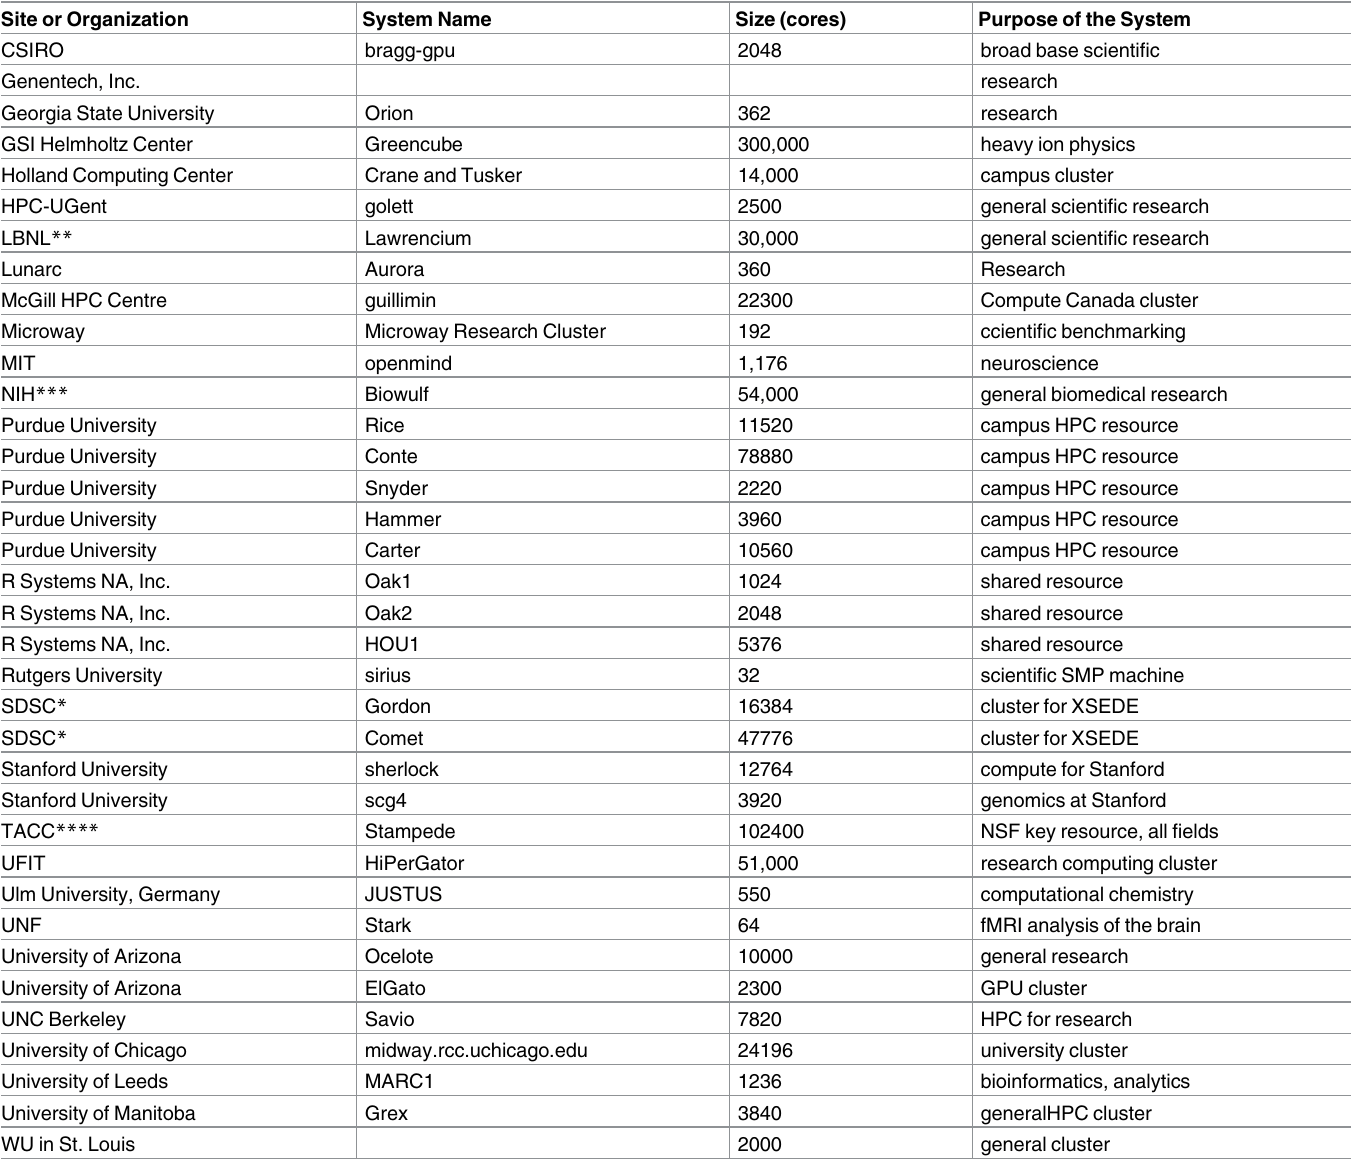
Table 4. Singularity reported usage.